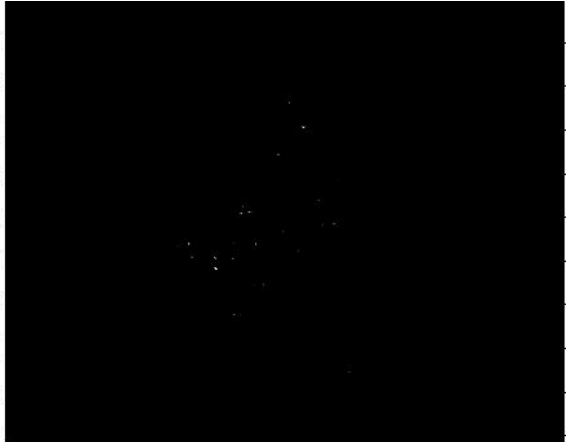
Figure 15. Experiment 1: One image at 20 cm from the cap face filtered, with parallax removed. Exposure time: 200 μ s. The dispersed distribution of the particles in a cross section of the air/particle jet 100 cm